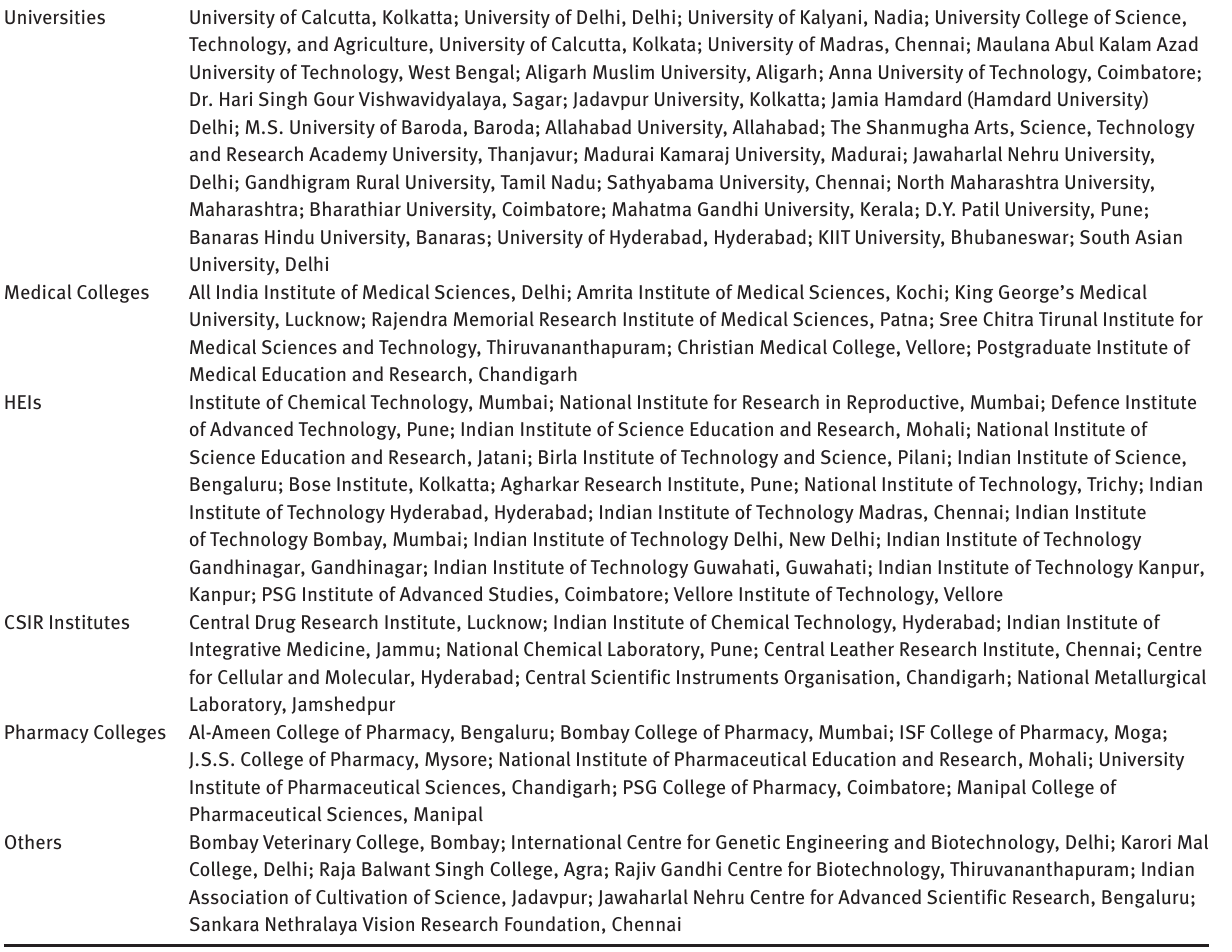
Table 2: An exhaustive list of universities and institutes with research focus on nanomedicine in India (source: compiled by authors from websites of funding agencies, publications, and